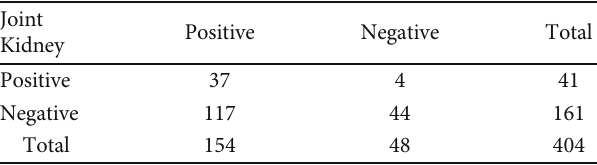
Table 6: Correlation of joint MSU deposition with